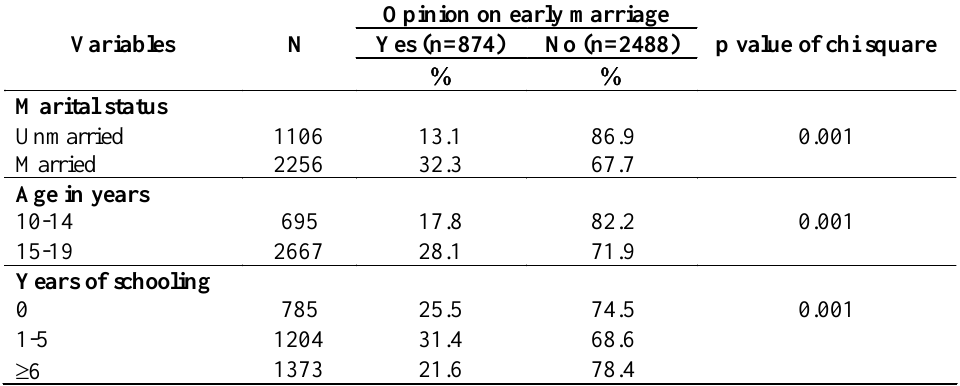
Table II : Percentage distribution of respondents by opinion in favour of early marriage and marital status, age and years of